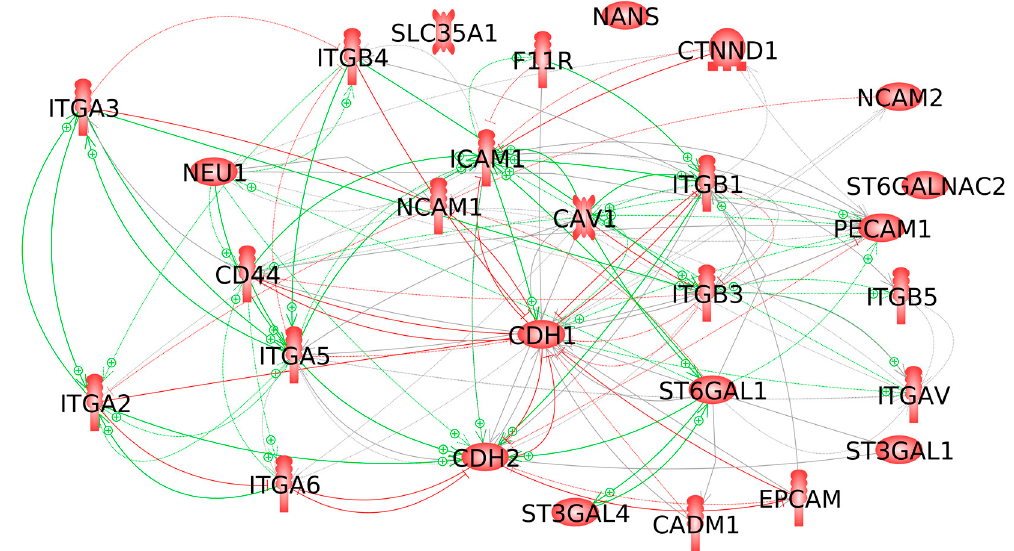
Figure 5. The mutual influence of selected entities at gene expression. Genes whose proteins were selected for a detail analysis by the network approach are shown. The green arrows indicate activating and the red arrows inhibiting effects. The grey lines indicate that interactions take place within the entities whose effects have not yet been clarified. The interaction network was built up using Elsevier Pathway Studio plus. Table 2. Proteins of MCF7 and FTC-133 cancer cells cultured under normal gravity (1 g ) or under simulated microgravity as adherent (AD) or as aggregated cells (MCS). The proteins were selected from recent proteome analyses [5,6] because they are involved in the sialylation of proteins. Uniprot accession numbers, genes, and label free quantitation values (LfQ) are indicated. MCF-7 FTC-133 Protein Gene 1 g AD